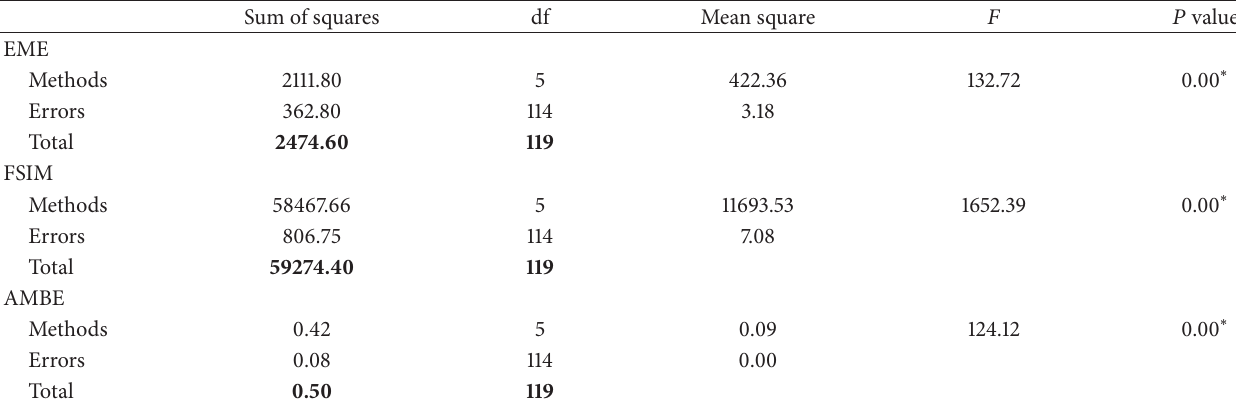
Table 2: The one-way ANOVA computed by using different contrast enhancement methods in EME, AMBE, and FSIM.